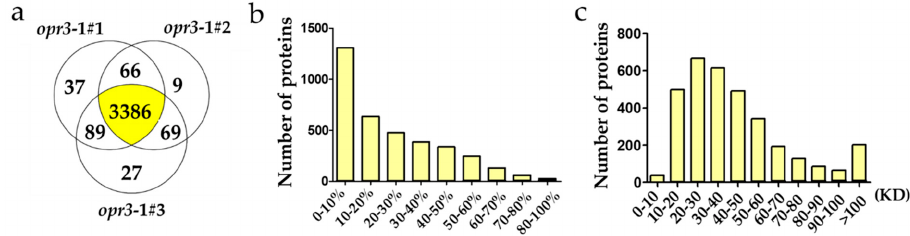
Figure 1. Information on the identified proteins. ( a ) A Venn diagram of the number of proteins identified in three replicates; ( b ) the distribution of sequence coverage; ( c ) the distribution of the mass of the identi fi ed